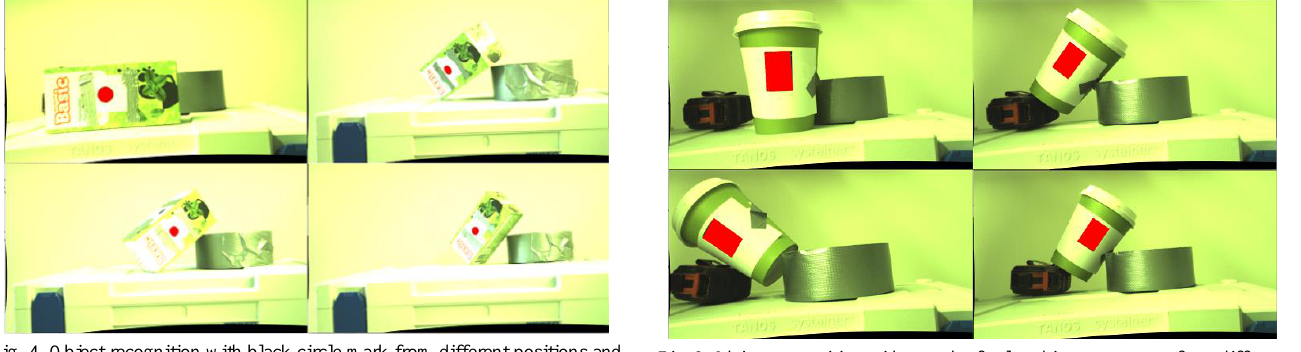
Fig. 8. Object recognition with a mark of colored image on a cup from different positions and orientation in a bright light condition.